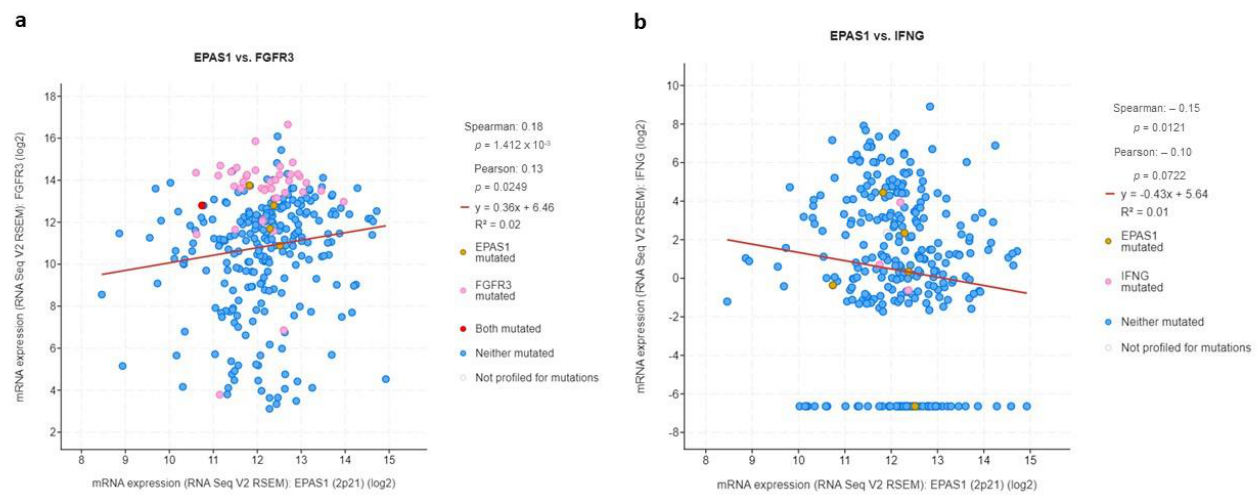
Figure 9. mRNA log2 expression of immune-modulating genes ( a ) FGFR3 and ( b ) IFNG in association with EPAS1